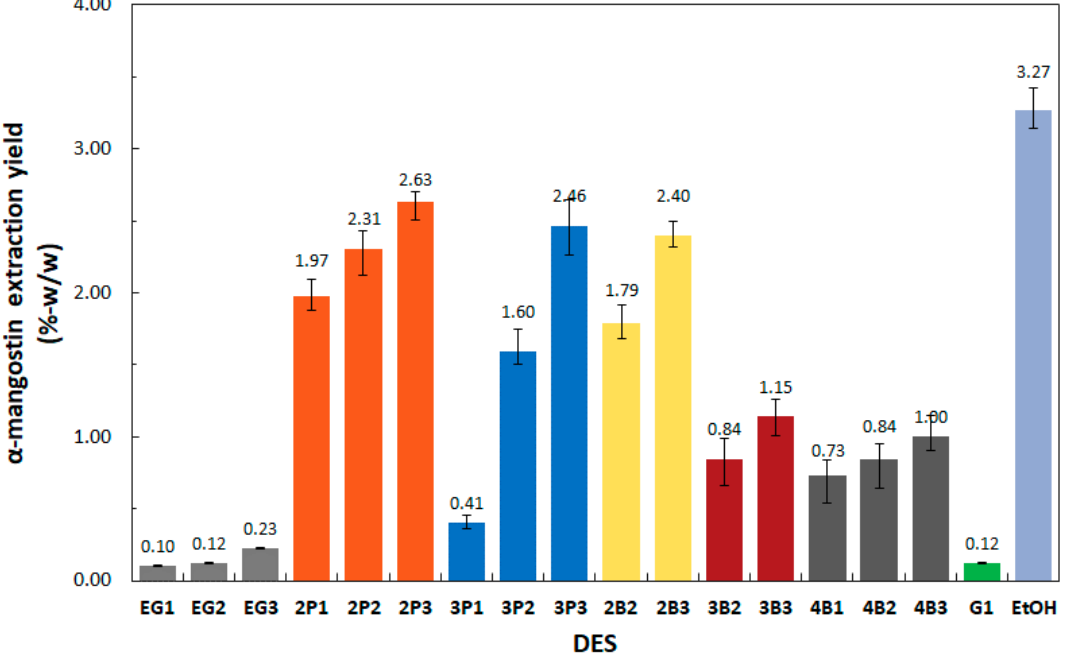
Figure 2. Extraction yield obtained using ChCl-polyalcohol DESs. The error bar indicates the maximum and minimum yields ( n = 3). Label: EG (ethylene glycol), 2P (1,2-propanediol), 3P (1,3-propanediol), 2B (1,2-butanediol), 3B (1,3-butanediol), 4B (1,4-butanediol), G (glycerol), EtOH (ethanol), last digit (mole ratio of polyalcohol to ChCl).